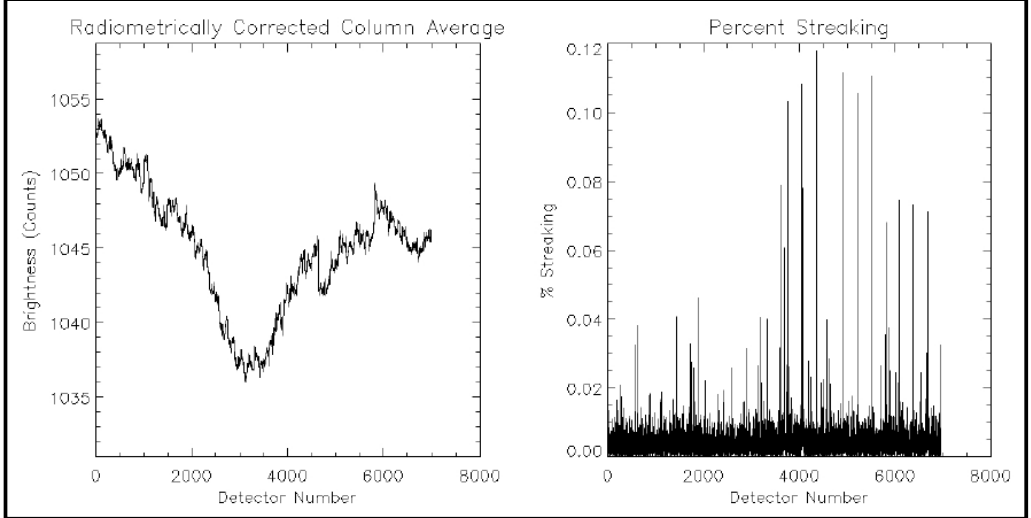
Figure 8. Radiometrically corrected desert data and corresponding percent streaking [127].